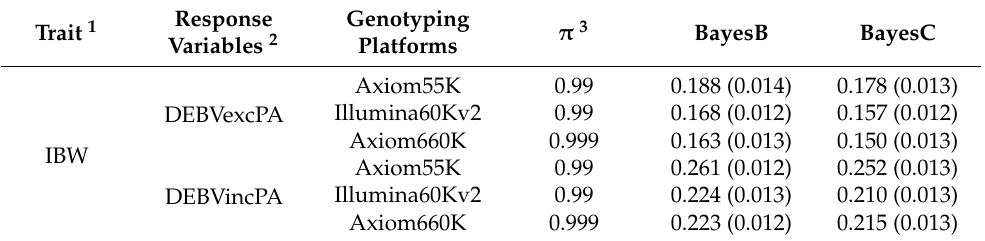
Table 4. Comparisons of the genomic prediction accuracy with standard error among genotyping platforms according to the Bayesian methods in each response